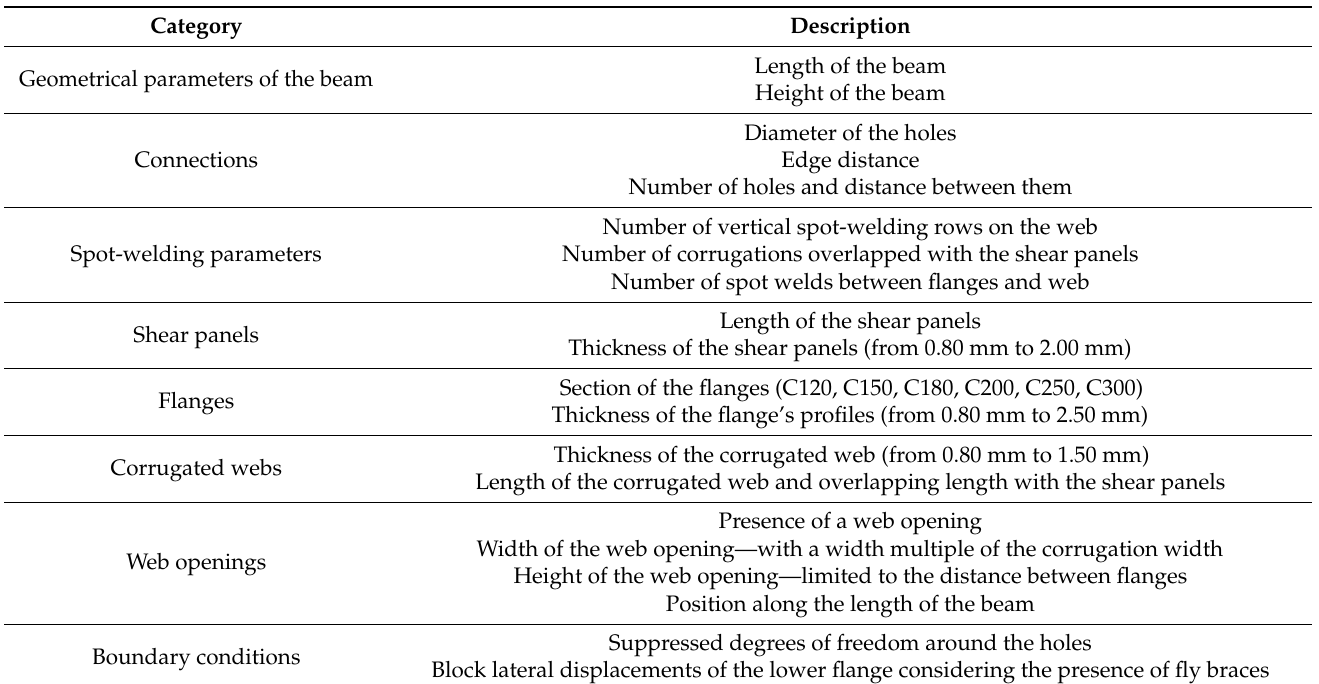
Table 1. Overview of the